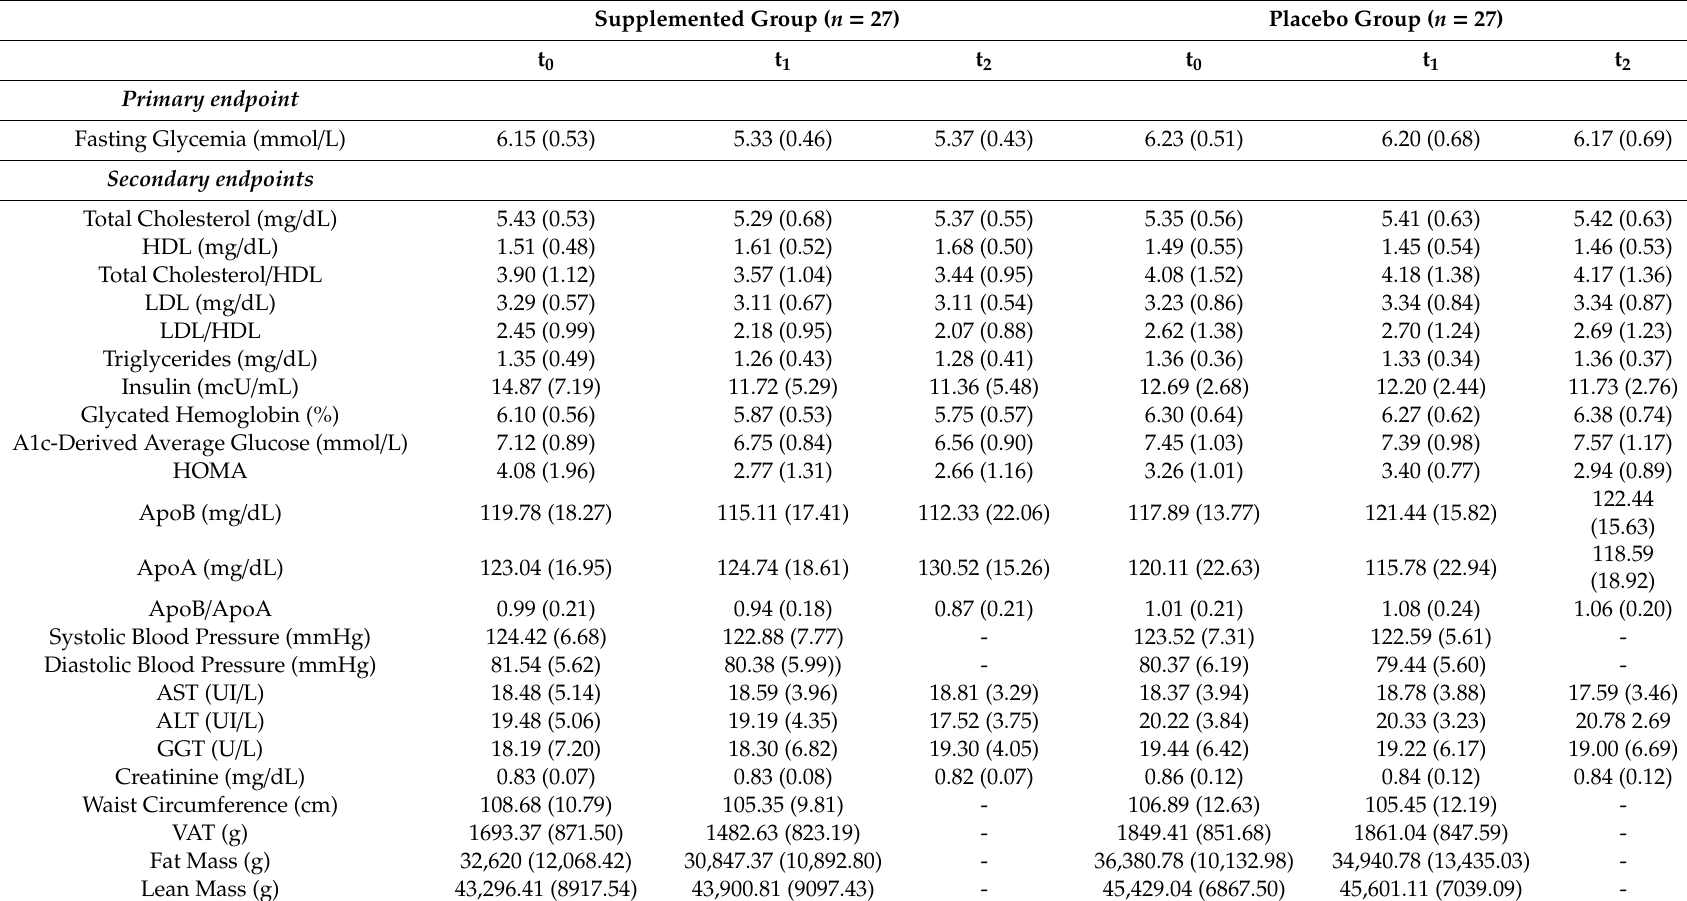
Table 2. Parameter values for each endpoint measured in the two groups at baseline (t 0 ), after 30 days (t 1 ) and after 60 days (t 2